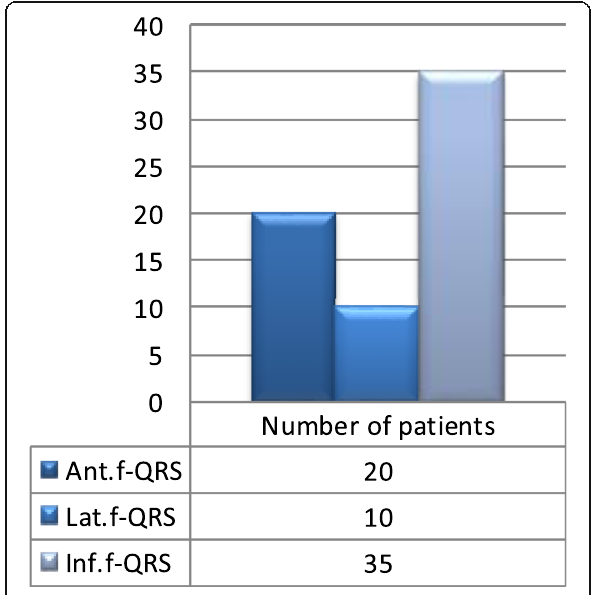
Fig. 3 Frequency of distribution of location of f-QRS